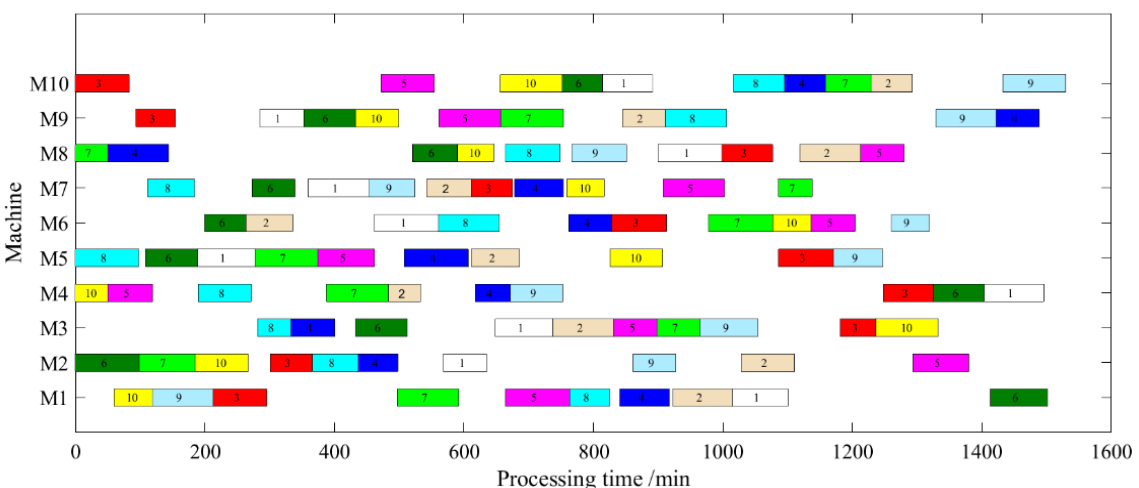
Figure 10. The Gantt chart for the RAND4 instance gained by the ISSA.